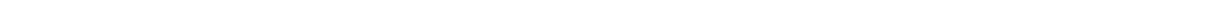
Figure 4 | CDR3 length and diversity within the V d 1 and V d 2 TCR. ( a ) Comparison of the mean ± s.e.m. from frequency-normalized CDR3 d and CDR3 g length spectratyping for V d 1 þ T cells in CMV neg ( n ¼ 5), CMV þ ( n ¼ 8), adult diverse ( n ¼ 7) and cord blood ( n ¼ 5) donors. ( b ) Comparison of non- normalized CDR3 d length spectratyping for V d 1 þ T cells from 3 representative individuals from CMV-seronegative (representative of n ¼ 5), CMV- seropositive (representative of n ¼ 8), adult diverse (representative of n ¼ 7) and cord blood (representative of n ¼ 5) donor groupings. ( c ) Non-normalized length spectratyping for CDR3 d and CDR3 g in adult V d 2 þ T cells ( n ¼ 4). ( d ) Length distribution and mean (red line) within the top 10 most prevalent clonotypes in CDR3 d (left two panels) and CDR3 g (right two panels) of V d 1 þ T cells (5 donors shown, representative of 20) and V d 2 þ T cells (from 4 donors). ( e ) Publicity in the 10 most prevalent clonotypes for each donor’s V d 1 þ TCR repertoire compared against all other donors (both aa and